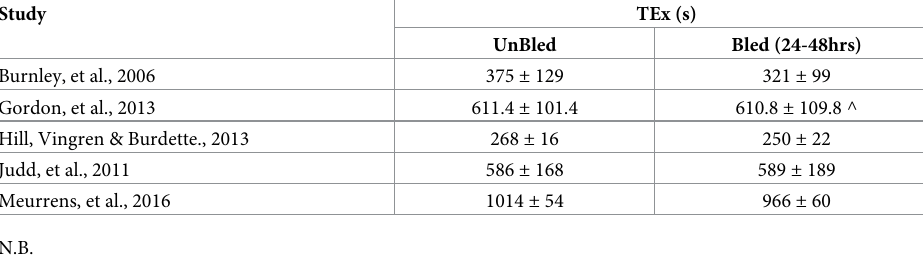
Table 4. TEx pre and post donation (Unbled and bled) values over various time periods.